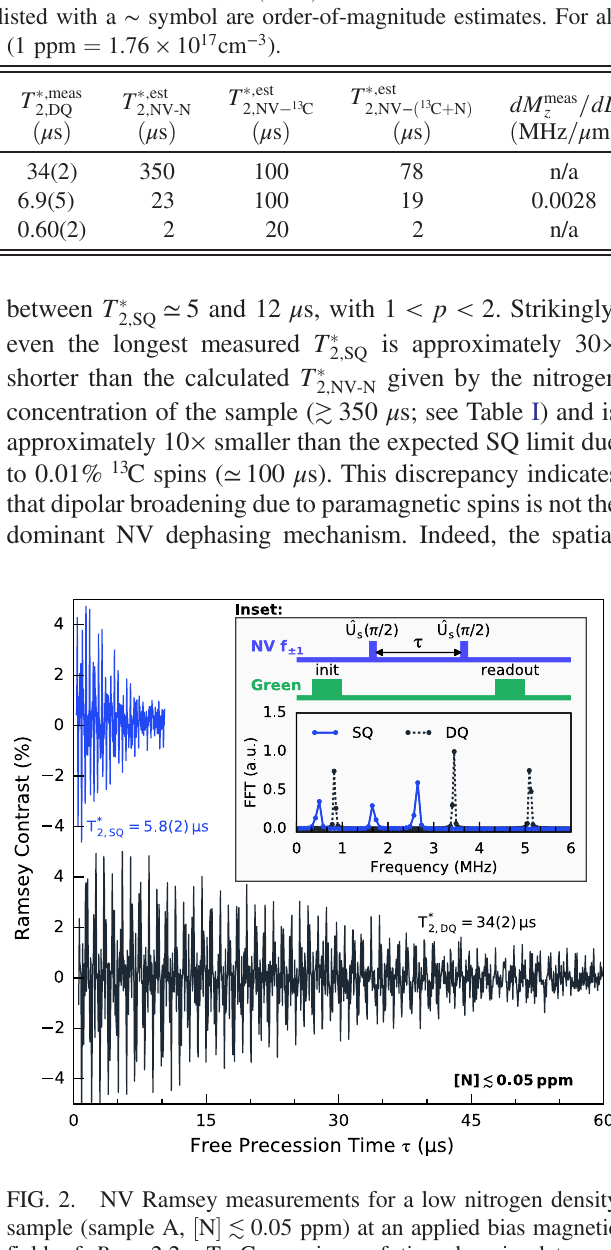
and twice the measured T (cid:1) ; meas 2 ; , 2 ; NV − ð 13 C þ N Þ DQ